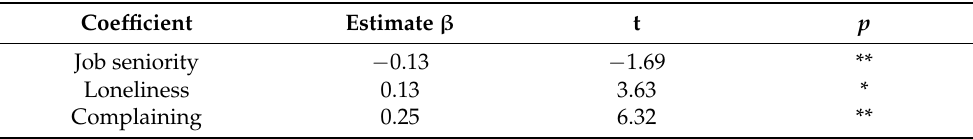
Table 3. Regression model for the variable of disengagement with significant predictors in the group of employees of psychiatric wards. Coefficient Estimate β t p Job seniority − 0.13 − 1.69 ** Loneliness 0.13 3.63 * Complaining 0.25 6.32